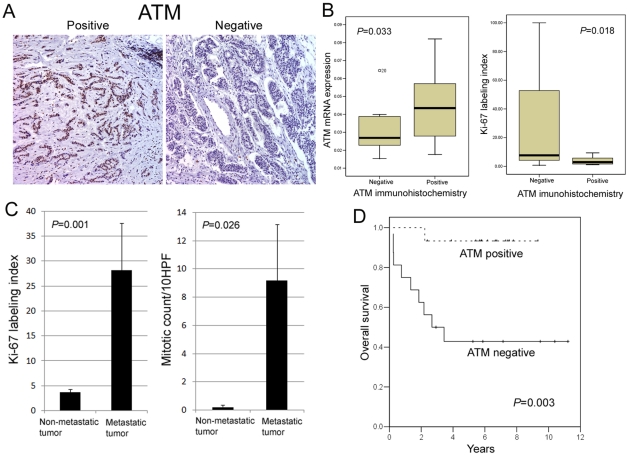
ATM immunohistochemistry in colorectal neuroendocrine tumors.ATM protein expression was significantly correlated with high ATM mRNA expression and low Ki-67 labeling index (A, B). Ki-67 labeling index and mean mitotic counts were increased in metastatic neuroendocrine tumors (C). Patients with negative ATM protein expression showed significantly shorter overall survival than patients with positive ATM protein expression (D).